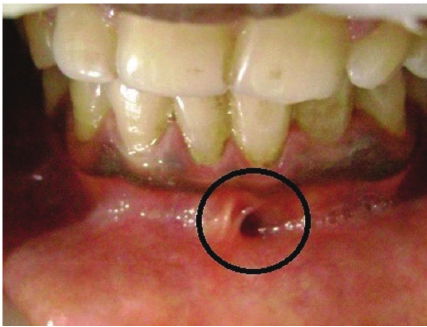
Figure 1: Clinical photograph showing draining sinus in relation to 31 and 32.